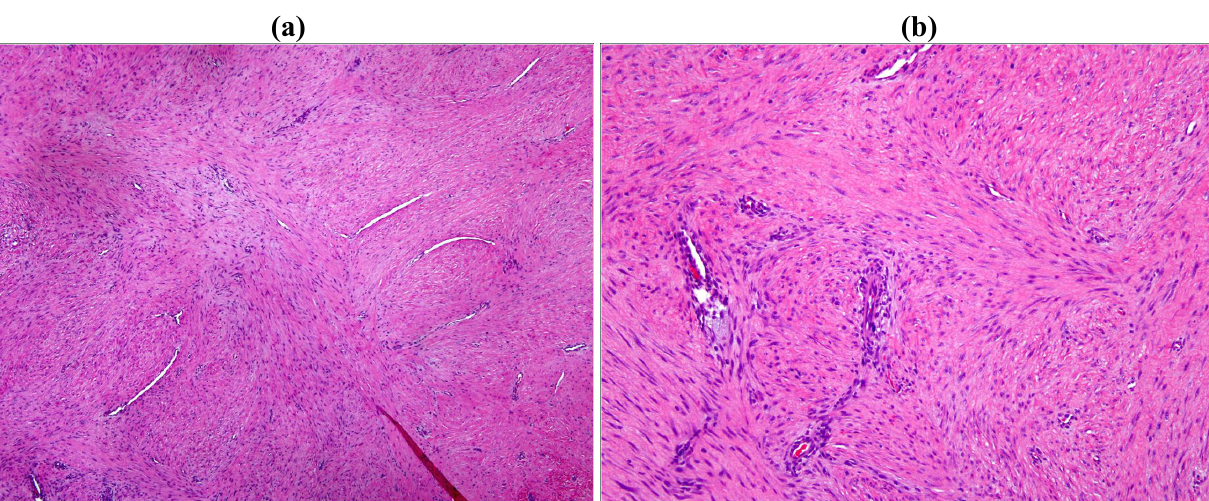
Figure 3. Typical histopathology pattern in low and high magnification for Desmoid Tumor. The lesion is poorly defined with infiltrative margins consisting of spindled fibroblasts arranged in broad sweeping fascicles separated by abundant collagen. The vessels, although thin-walled, are seen at scanning magnification. The nuclei of the proliferating lesion are lighter than those of the endothelial cells, and the smooth muscle cytoplasm in vessel walls is pinker than the surrounding myofibroblastic cytoplasm of the tumor cells. Mitotic figures are infrequent. (a) Low magnification; (b) High magnification.